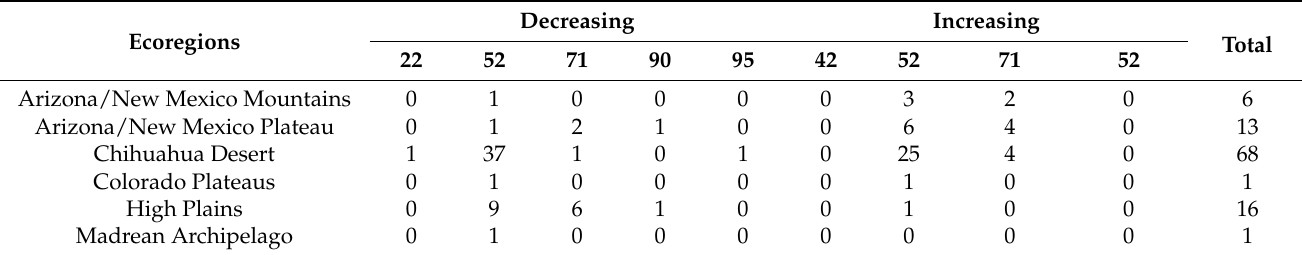
Table A2. Allocation of the randomly selected pixels as identified with Segmented RESTREND method over the different land cover classes based on the National Land Cover Dataset of 2011 (NLCD 2011) along with the corresponding ecoregions.